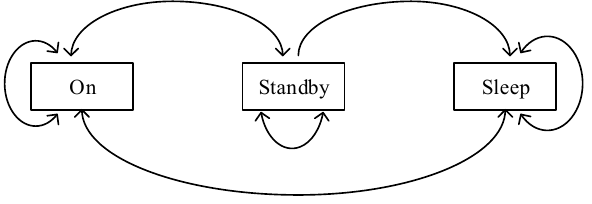
Figure 2. Base station status transfer map.